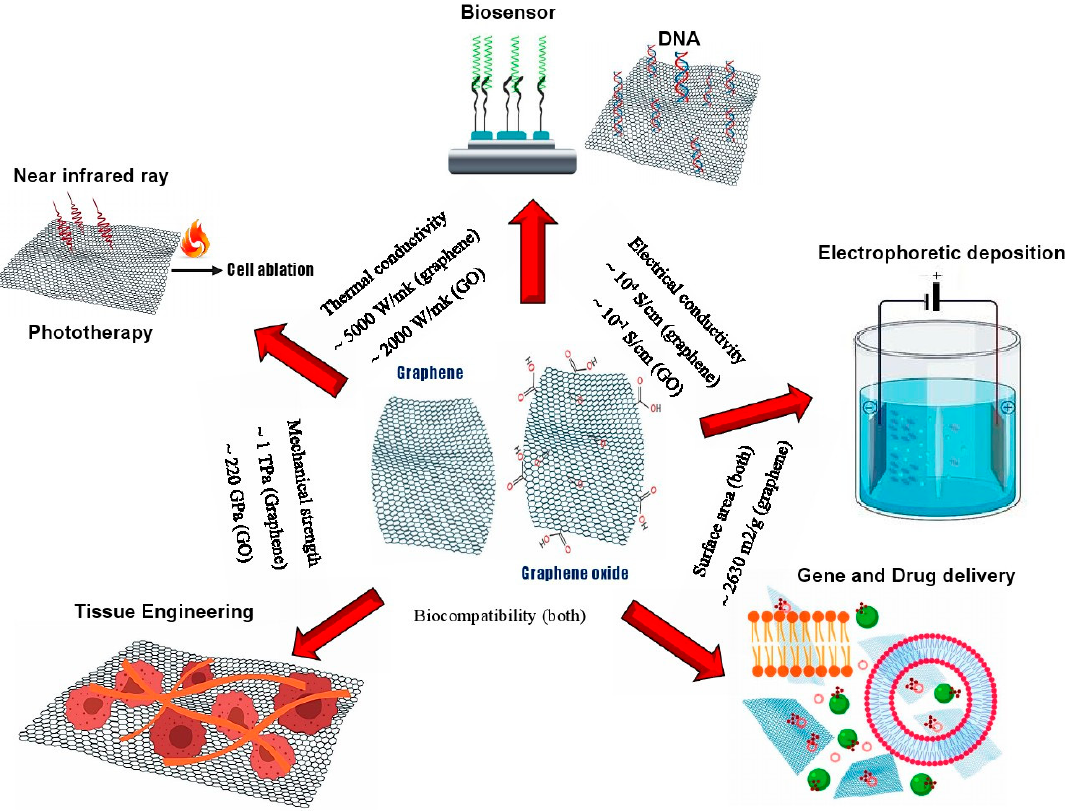
Figure 1. Schematic representation of some of the application of graphene family nanomaterials (GFNs) reproduced from [31], with permission Elsevier, 2019.